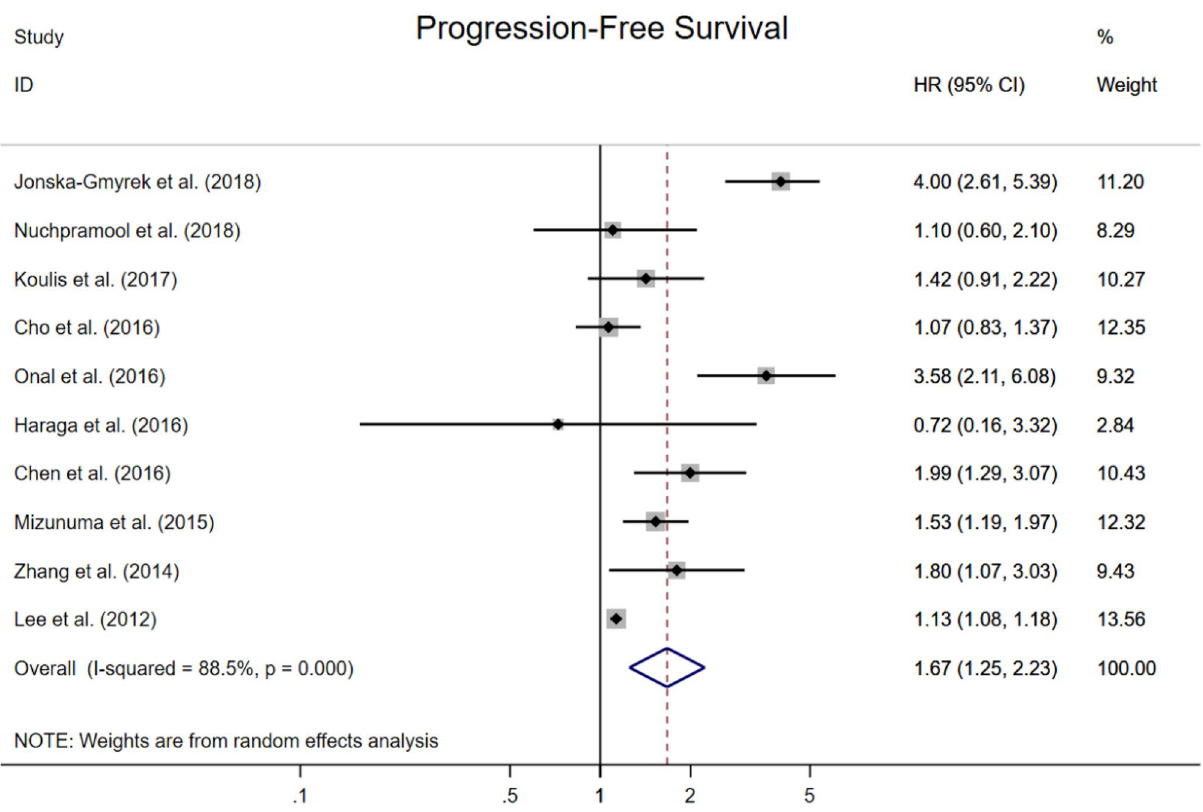
FIGO Stage: IB1–IIA; Zhang et al. 40 FIGO Stage: I–II) and one focused on FIGO Stage II–III, while other studies